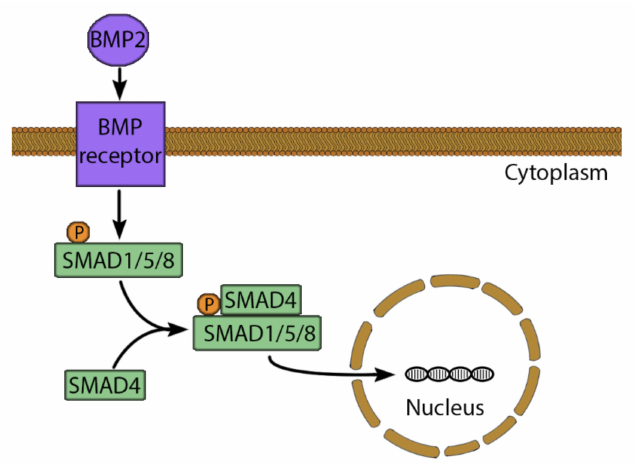
Figure 4. The BMP-2 signaling pathway. BMP-2 binds to a serine/threonine kinase receptor, leading to phosphorylation and activation of SMAD1/5/8. Therefore, SMAD4 can bind to SMAD1/5/8 to form a complex. This complex moves to the nucleus and binds to a specific SMAD binding element. This stimulates the expression of osteogenic genes such as RUNX2 and